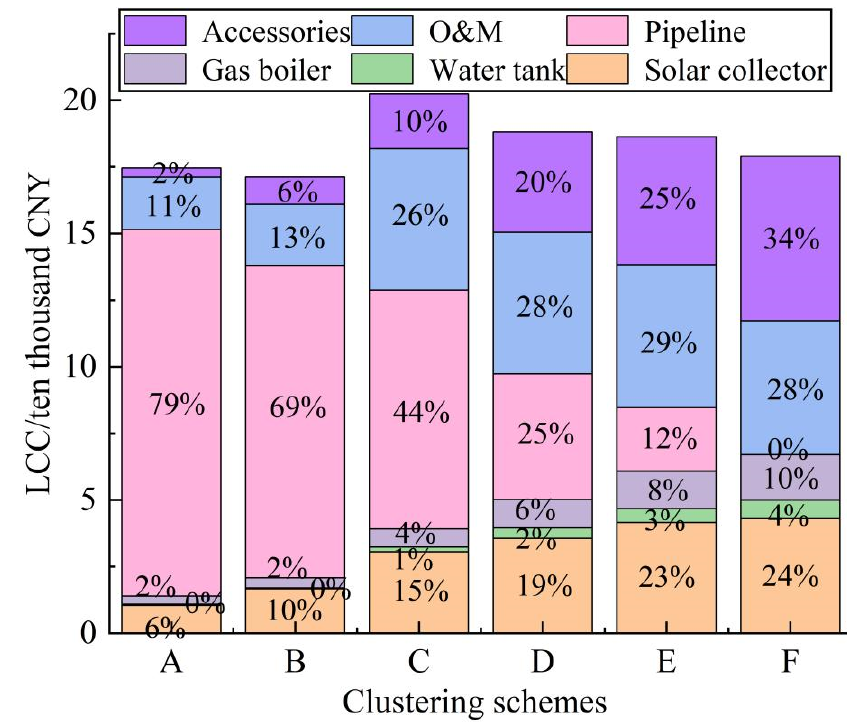
Figure 8. Variation of LCC under different clustering schemes.